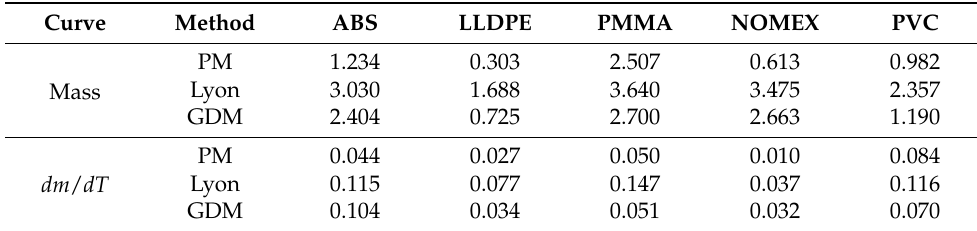
Table 6. Mean absolute error of mass- T and dm / dT-T responses versus experimental results for five polymer materials obtained by different methodologies. Curve